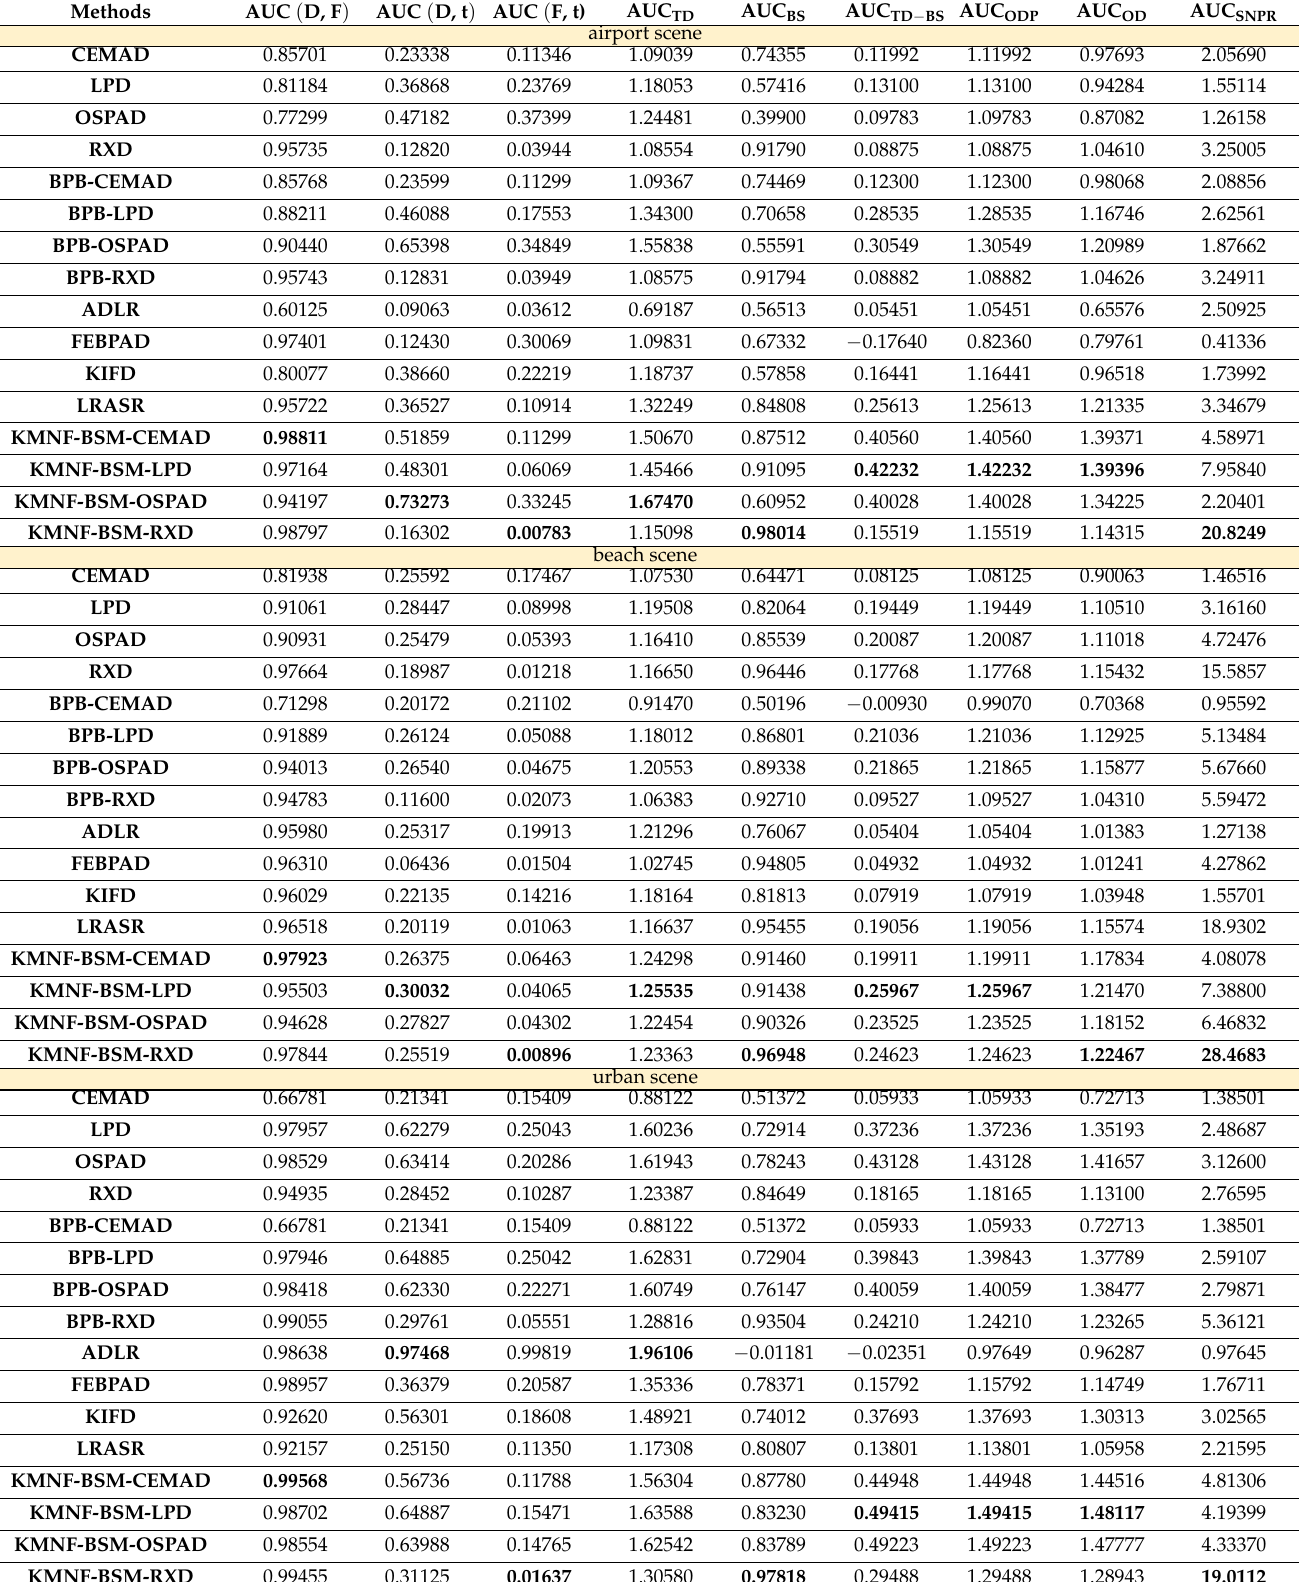
Table 2. The AUC values calculated from the three 2D ROC curves for HSIs over different